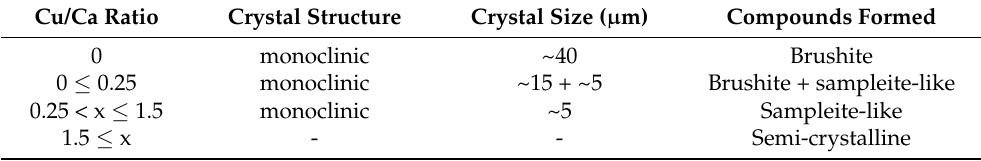
Table 5. Phase evolution, crystal size, and structure as functions of Cu/Ca molar ratio in solution. Cu/Ca Ratio Crystal